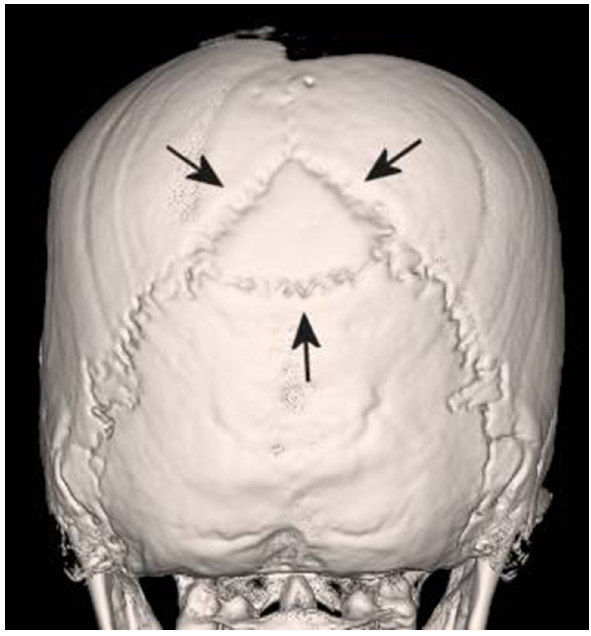
Figure 3. Paleoradiology – The Wormian ‘‘Inca’’ bone. Three- dimensional reconstruction of the head with back view demonstrating an Inca bone. This anatomical variation represents an additional bone in the lambdoid suture. The present type of Inca bone is typically seen in South American populations, but not in European ones.